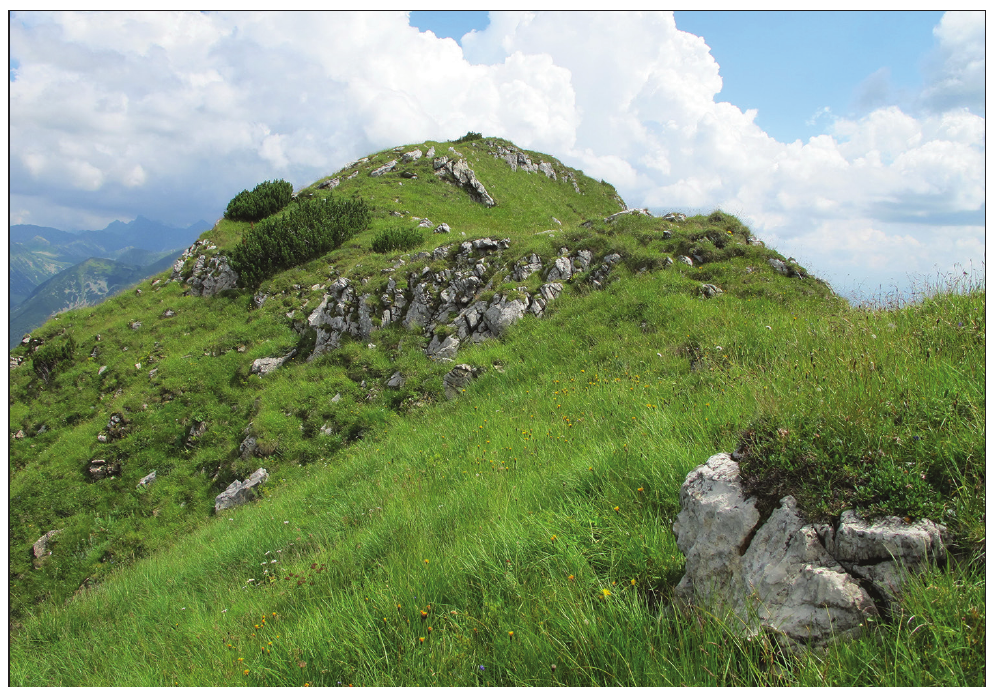
Figure 7. The Western Tatra Mts, Red Mts, Stoly Rocks, 29.vii.2005, locality where the first adults of Stig - mella tatrica were obtained. Photograph Z.